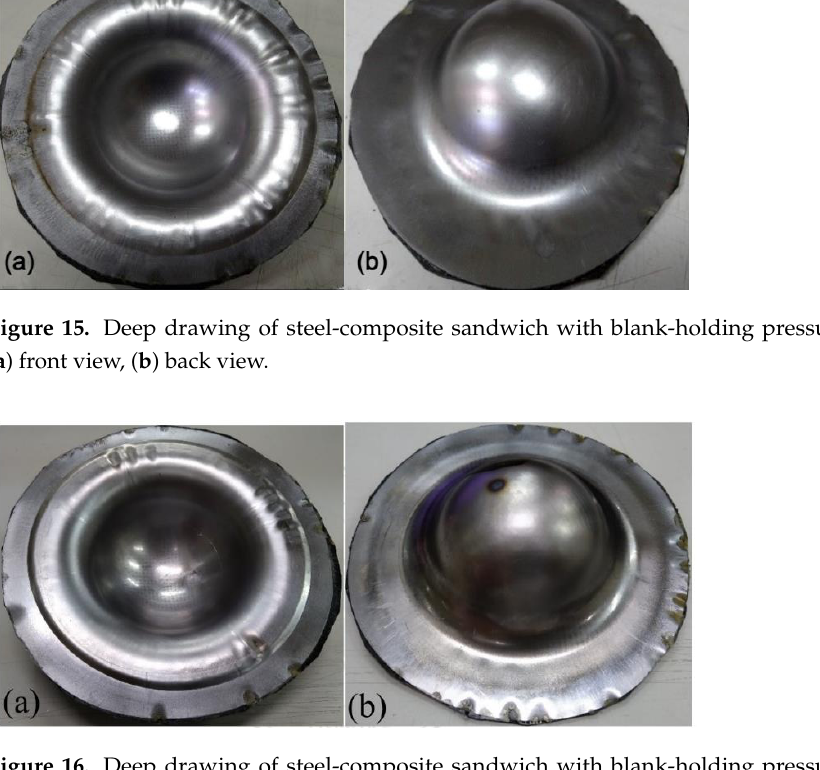
Figure 14. Deep drawing of steel-composite sandwich with blank-holding pressure of 1.1 MPa: ( a ) front view, ( b ) back view.